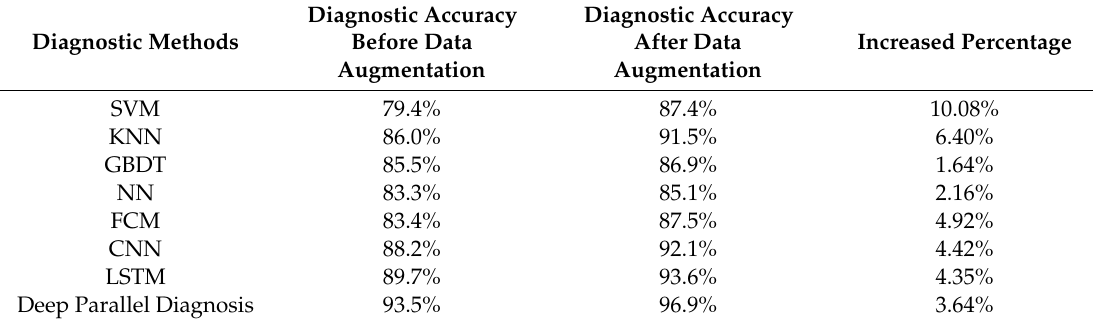
Table 7. Diagnostic e ff ects of di ff erent diagnostic methods before and after data